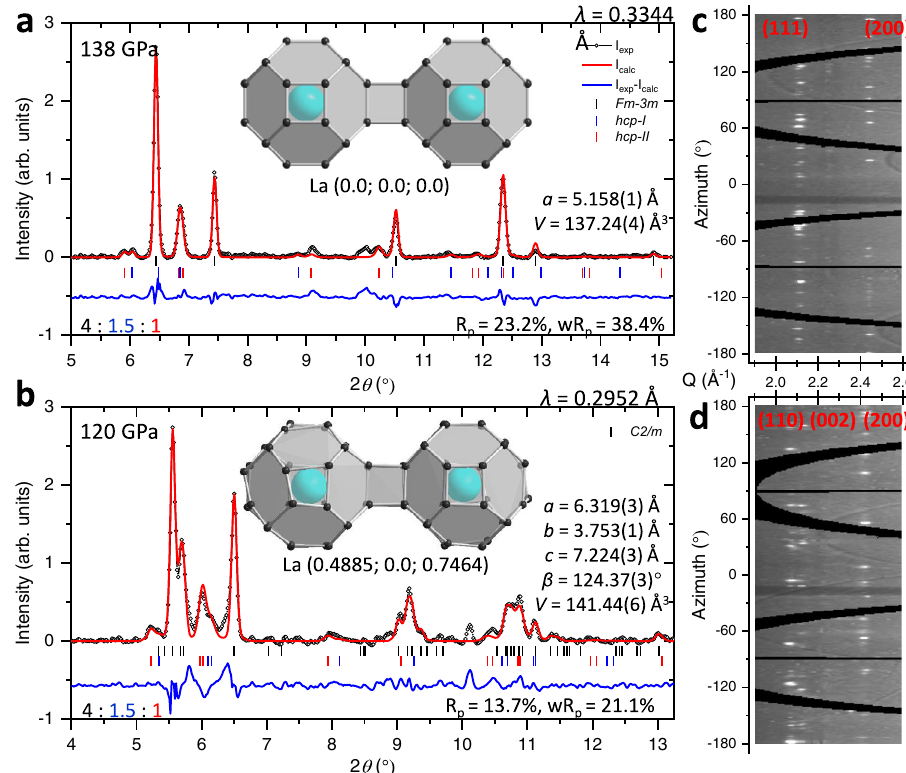
Fig. 1 Structural data for LaH 10 synthesized from La and excess H 2 . a , b Rietveld re fi nement for Fm-3m phase of LaH 10 at 138GPa and C2/m phase of LaH 10 at 120GPa, respectively. The peaks originating from the hcp-I ( a = 3.668(4)Å; c = 5.914(11)Å; V = 68.9(1)Å 3 at 138GPa) and hcp-II ( a = 3.750(3)Å; c = 5.561(7)Å; V = 67.7(1)Å 3 at 138GPa) impurity phases are indicated through blue and red dashes, respectively. The re fi ned ratio between the main and the impurity phases is provided in the left bottom corner of each fi gure. The main structural building block, two connected LaH 32 polyhedra, are shown in the middle inserts for each phase. Large blue and small black spheres correspond to La and H atoms, respectively. c , d The original powder X-ray diffraction patterns at 138 and 120GPa, respectively. New re fl ections appear at 120GPa due to the monoclinic distortions.